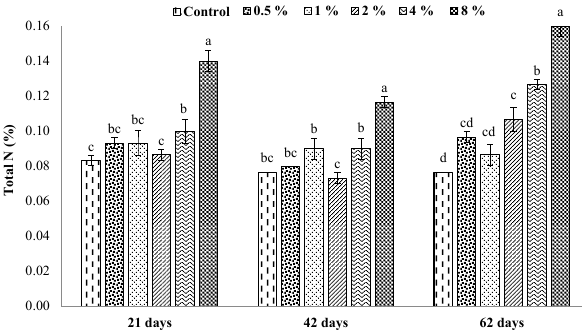
Figure 6. Effects of different rates of SMC application on total ni- trogen (mean ± SD<0.05). Means followed by the same letter are not statistically different as determined by a least significant differ- ence